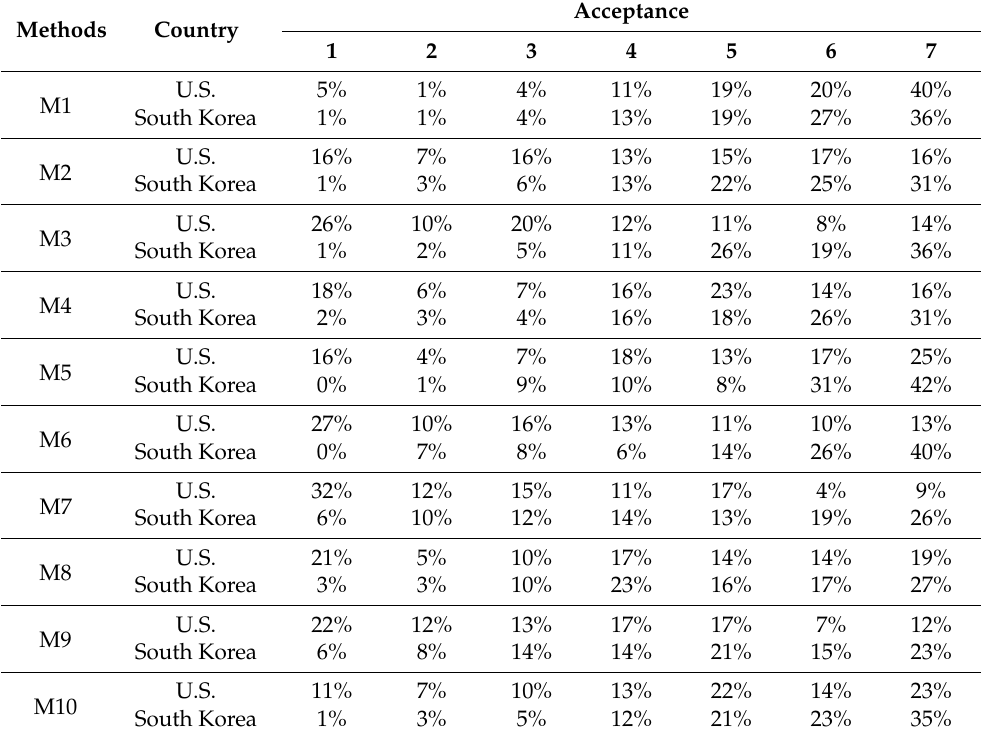
Table A4. Frequency of the acceptance levels for 10 methods (U.S. and South Korea). Methods